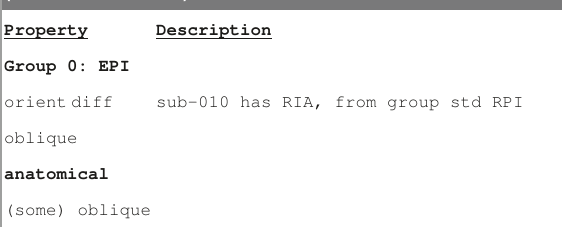
TABLE 4 Summary of the first stage of task-based FMRI QC: GTKYD (“getting to know your data”). GTKYD: “Getting To Know Your Data” results (task-based